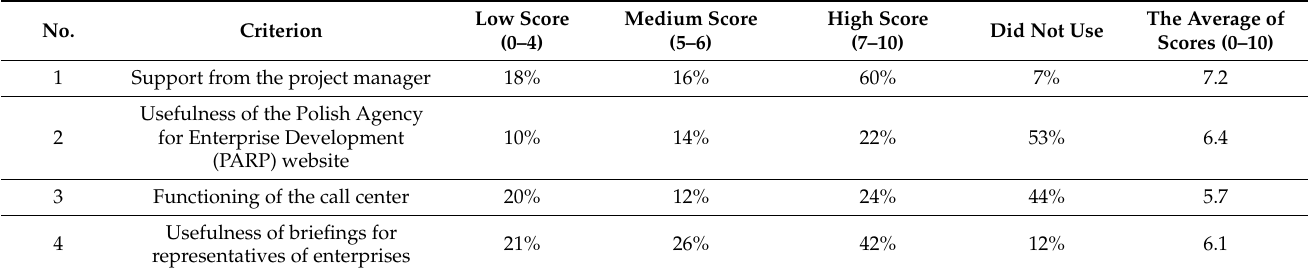
Table 6. The evaluation of individual tasks within the innovation implementation